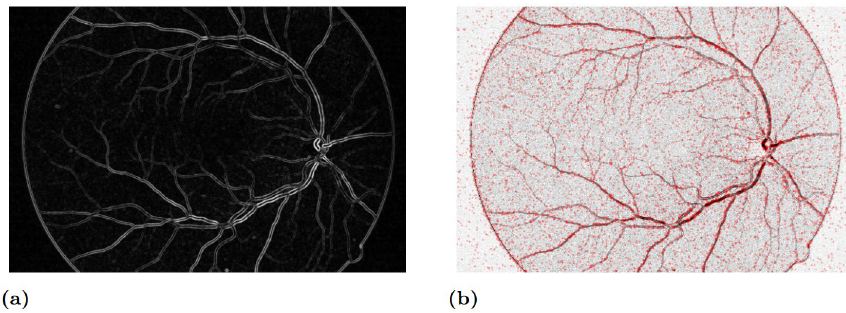
Fig 2. Gradient-weighted stochastic sampling of points on a retinal image. (a) Probability mass function (11) with σ GM = 5.0 (normalized); (b) 10000 sample points overlaid on the image as red semi-transparent markers.